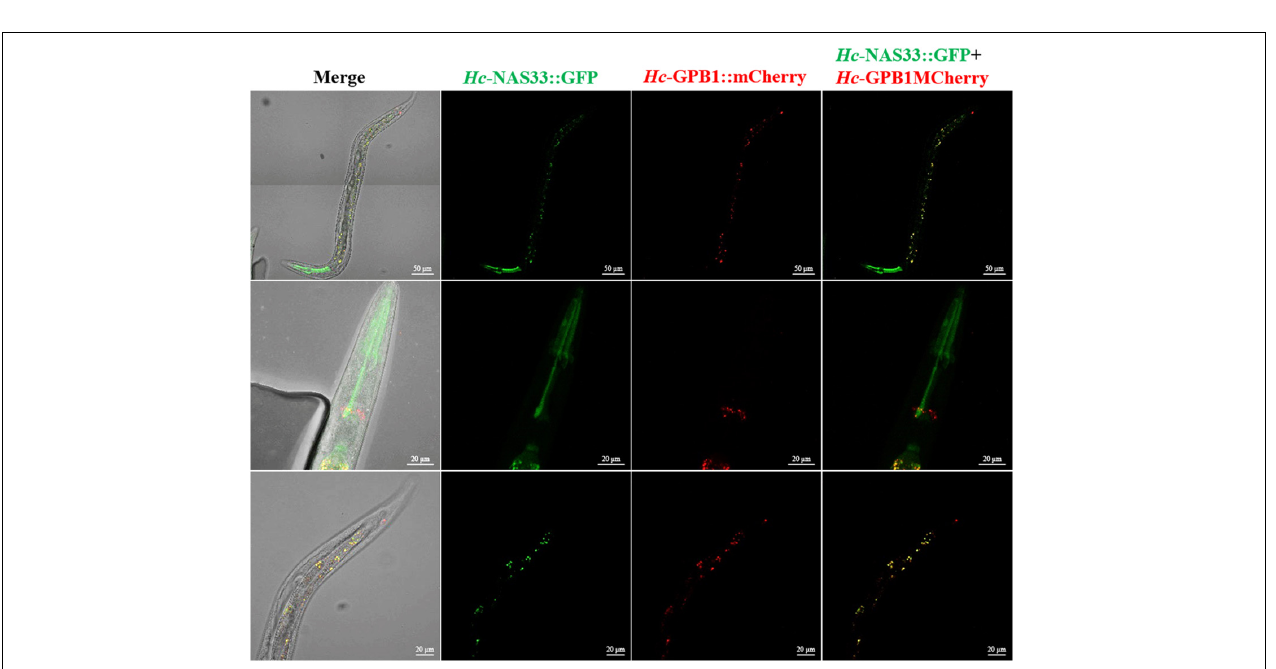
FIGURE 5 | Co-localization of Hc -NAS-33 and Hc -GPB-1 in C. elegans . GFP, green fluorescent protein; mCherry, monmer cherry fluorescent protein.